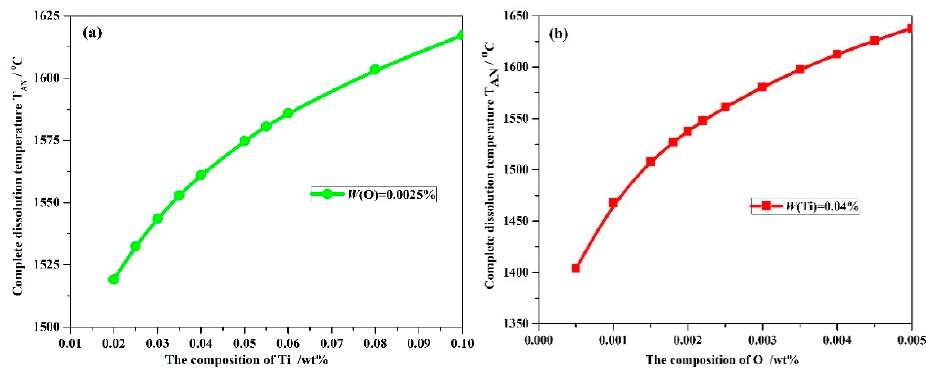
Figure 1. Complete dissolution temperature T AN , °C changes with: ( a ) O composition, wt % and ( b ) Ti composition, wt % in molten steels.